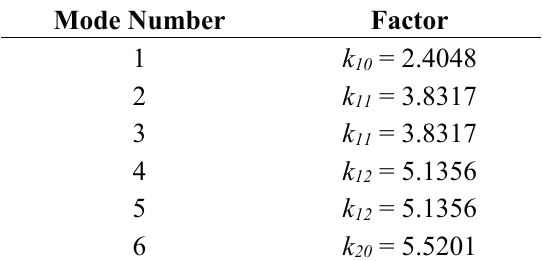
derived from the roots of the Bessel functions of the first kind for Table 1. Values of (cid:1863) (cid:3036)(cid:3037) first six